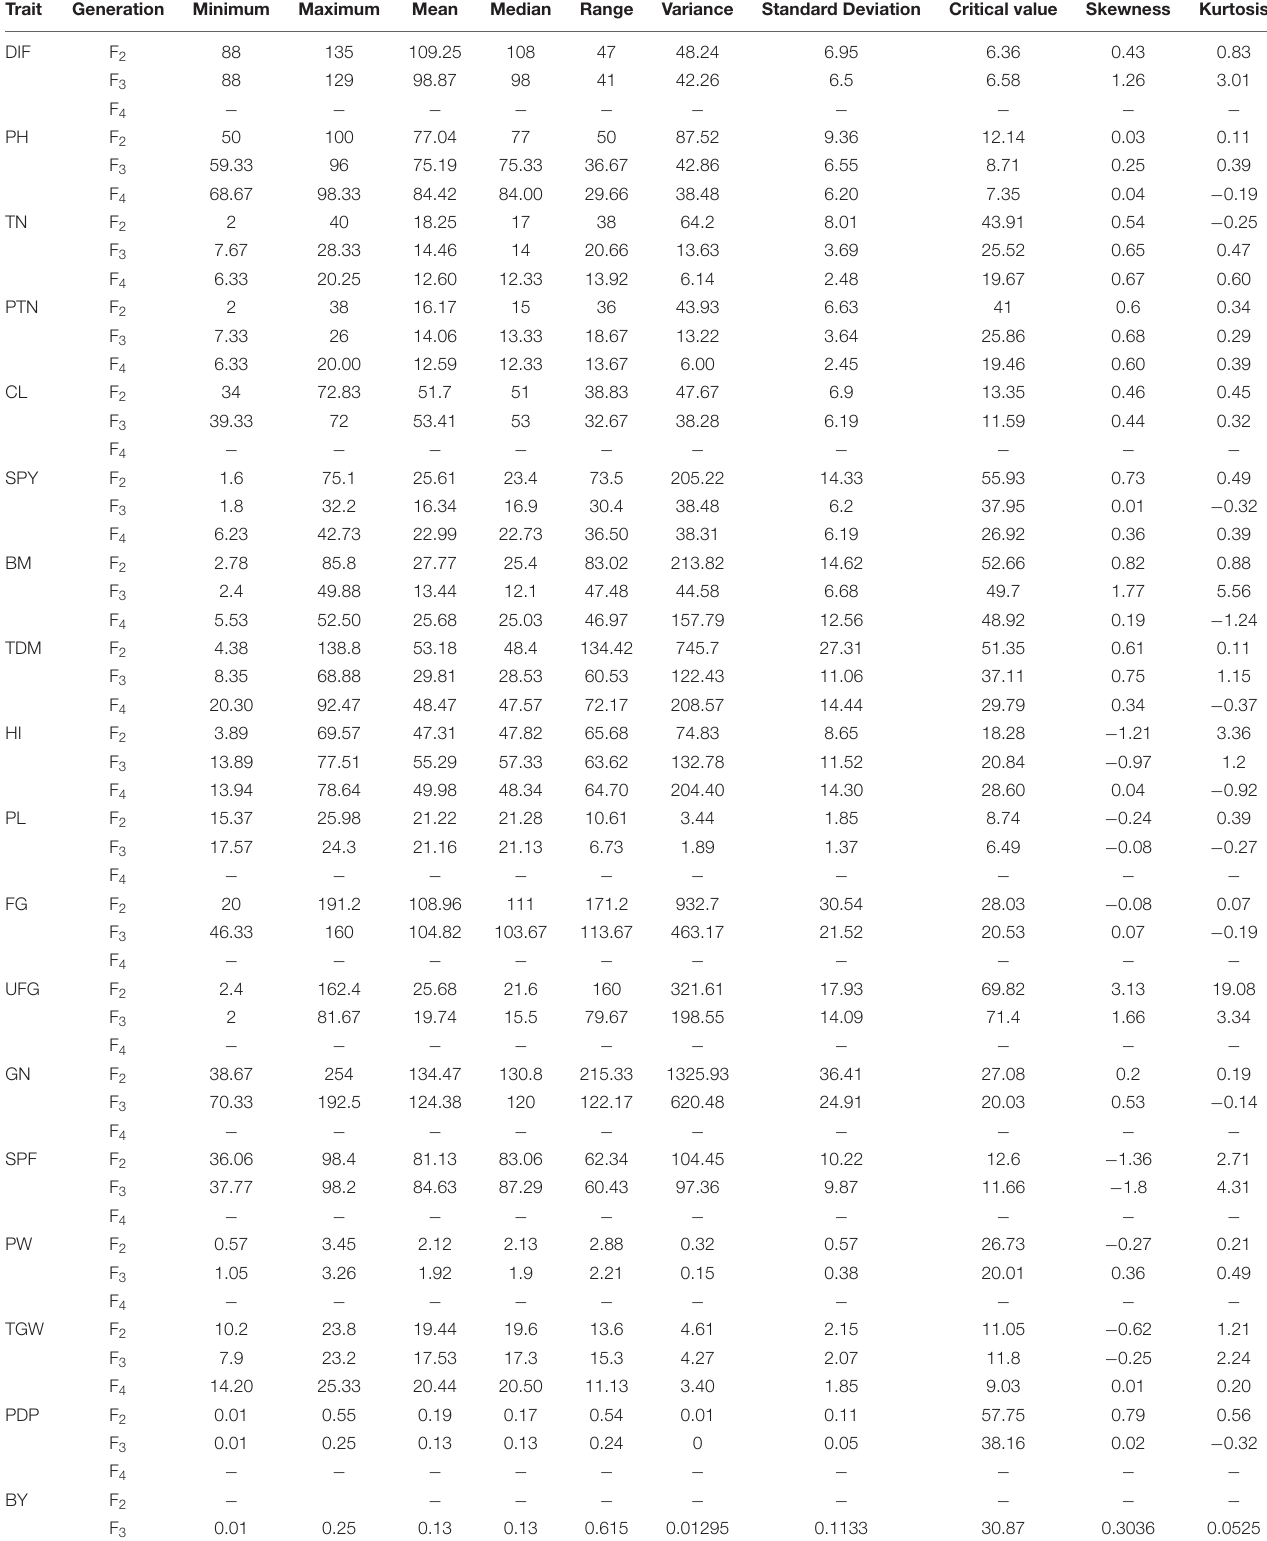
TABLE 1 | Descriptive statistics for the yield-related traits in F 2 , F 3 , and F 4 population of 166s × 14s. Trait Generation Minimum Maximum Mean Median Range Variance Standard Deviation Critical value Skewness